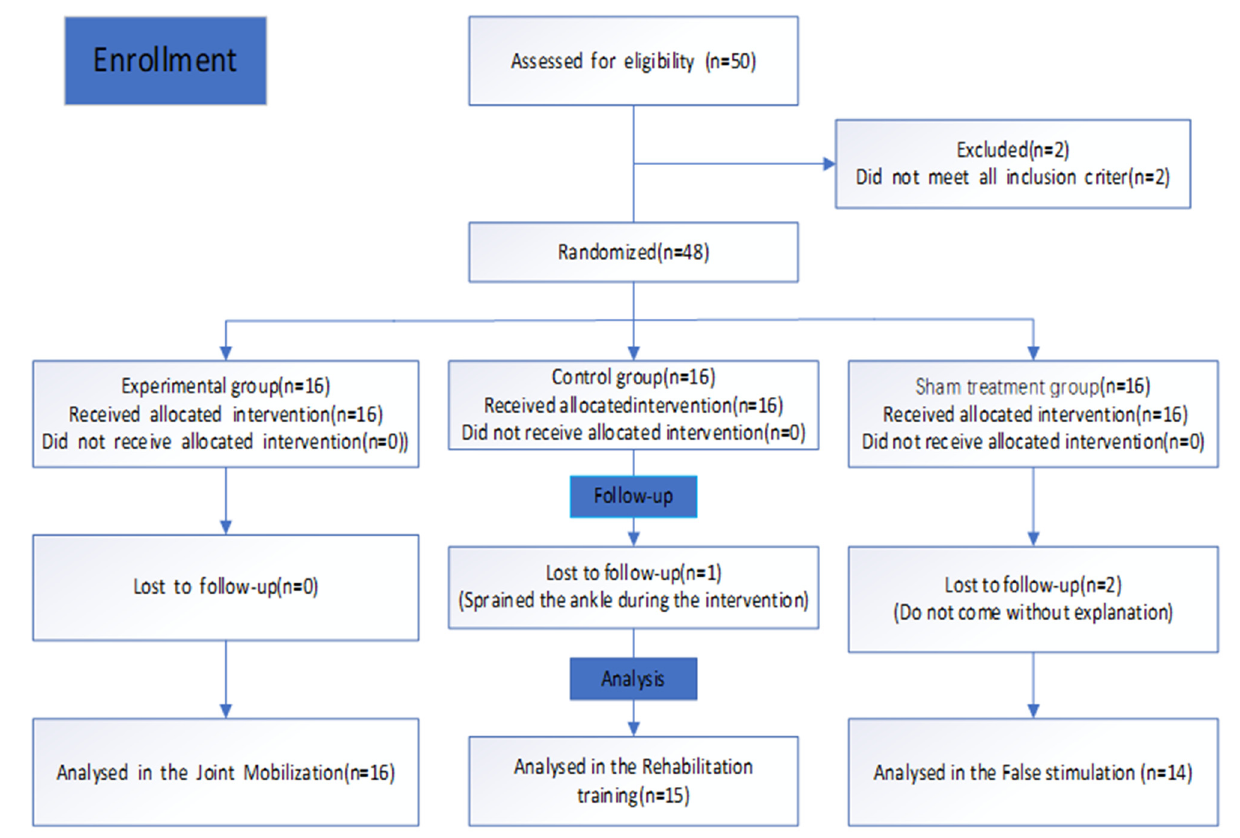
Figure 1. Flow diagram. Table 2. Descriptive data of subjects in each group. Data are reported as mean ±